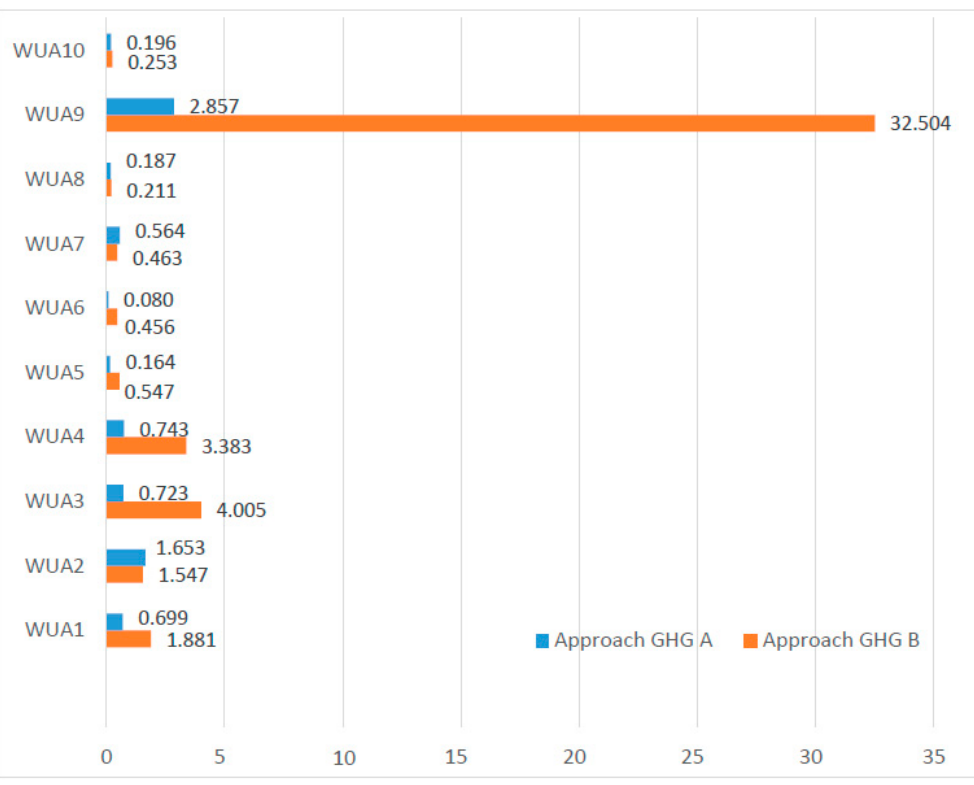
Figure 3. Approaches A and B, GHG emissions (MkgCO 2 e).